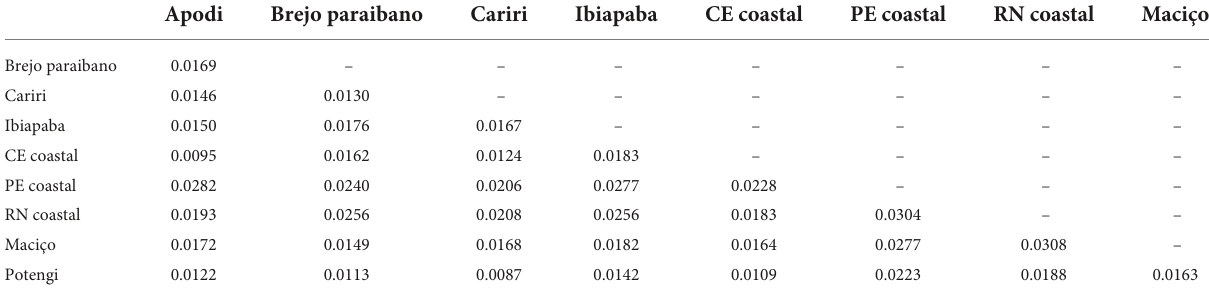
TABLE 4 Procrustes distances between regions obtained from the anatomical landmarks of the wings of Plebeia flavocincta